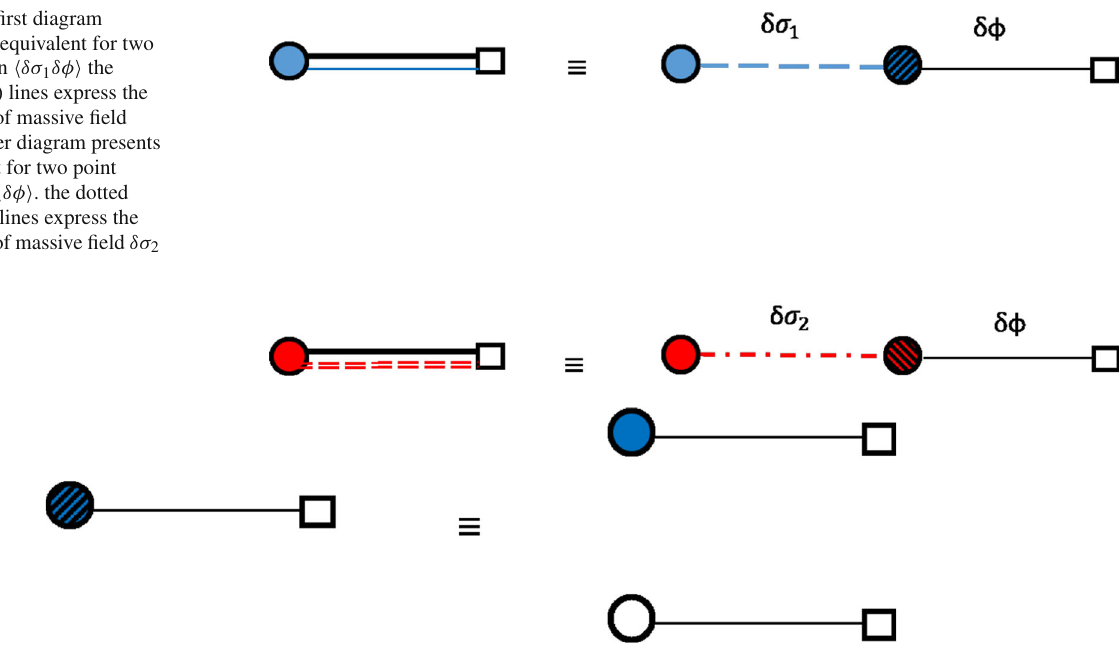
Fig. 2 The first diagram expresses an equivalent for two point function (cid:6) δσ 1 δφ (cid:7) the dashed (blue) lines express the propagators of massive field δσ 1 . The latter diagram presents an equivalent for two point function (cid:6) δσ 2 δφ (cid:7) . the dotted dashed (red) lines express the propagators of massive field δσ 2